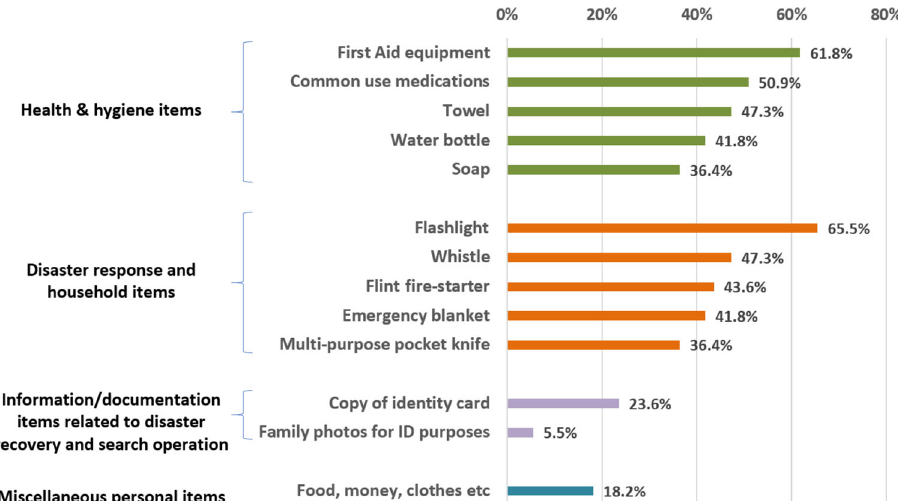
Fig. 2 Knowledge retention of items to be included in a disaster preparedness kit in earthquake-prone Ma’an Qiao Village, Sichuan in 2018*. Note The surveyed items were developed according to the five core components that support human survival and maintain health in disasters and emergencies (The Sphere Project 2011; Chan 2018). For